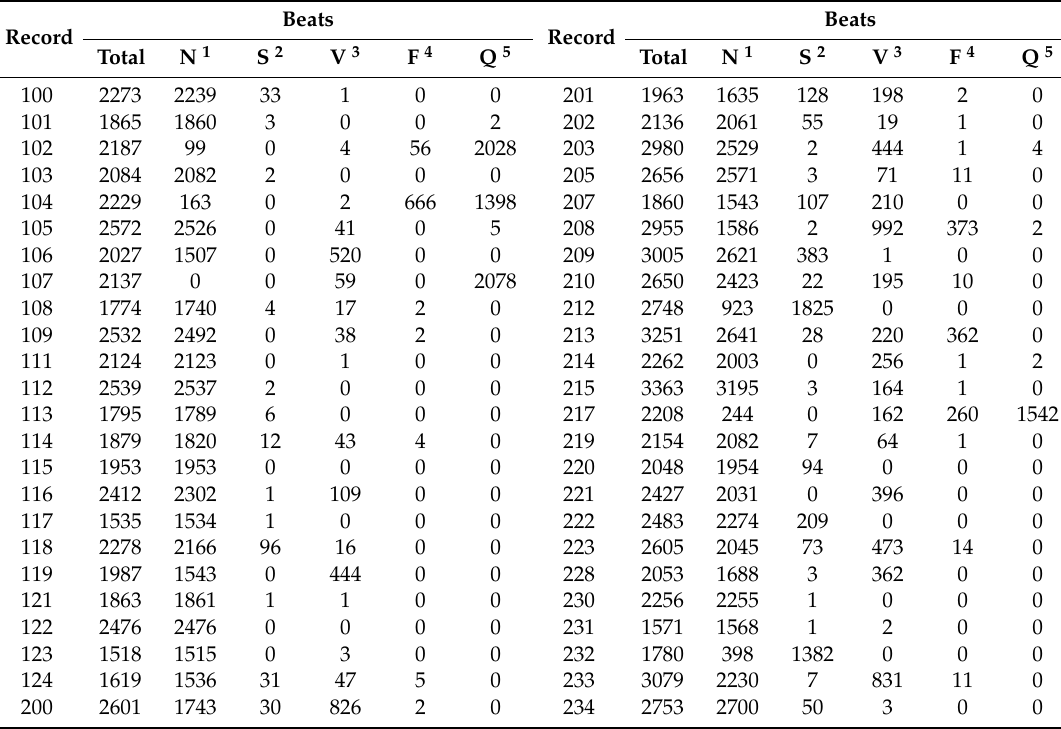
Table 1. The MIT-BIH Arrhythmia